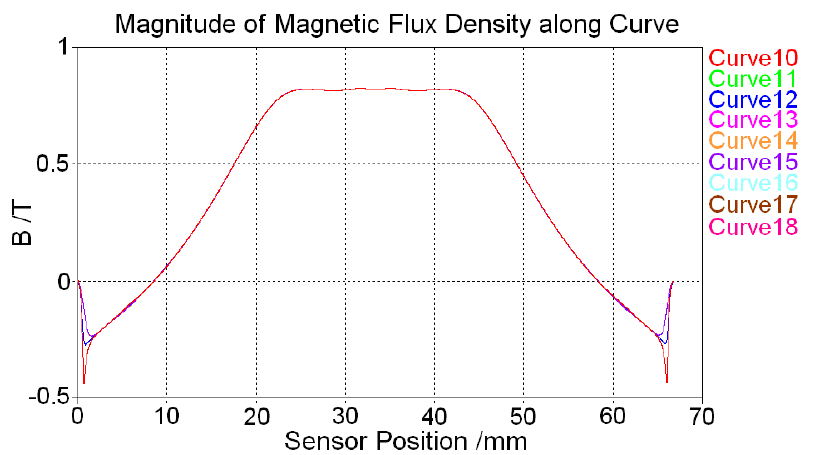
Figure 7. Magnetic field distribution in the feedback line.